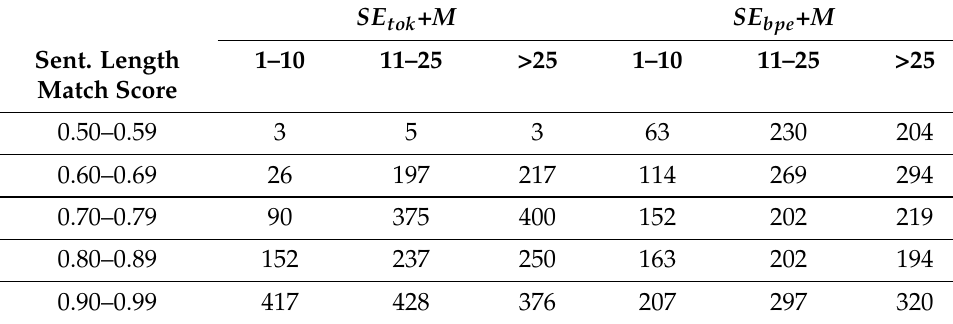
Table A6. Bin sizes per match range and sentence length (in number of words) for